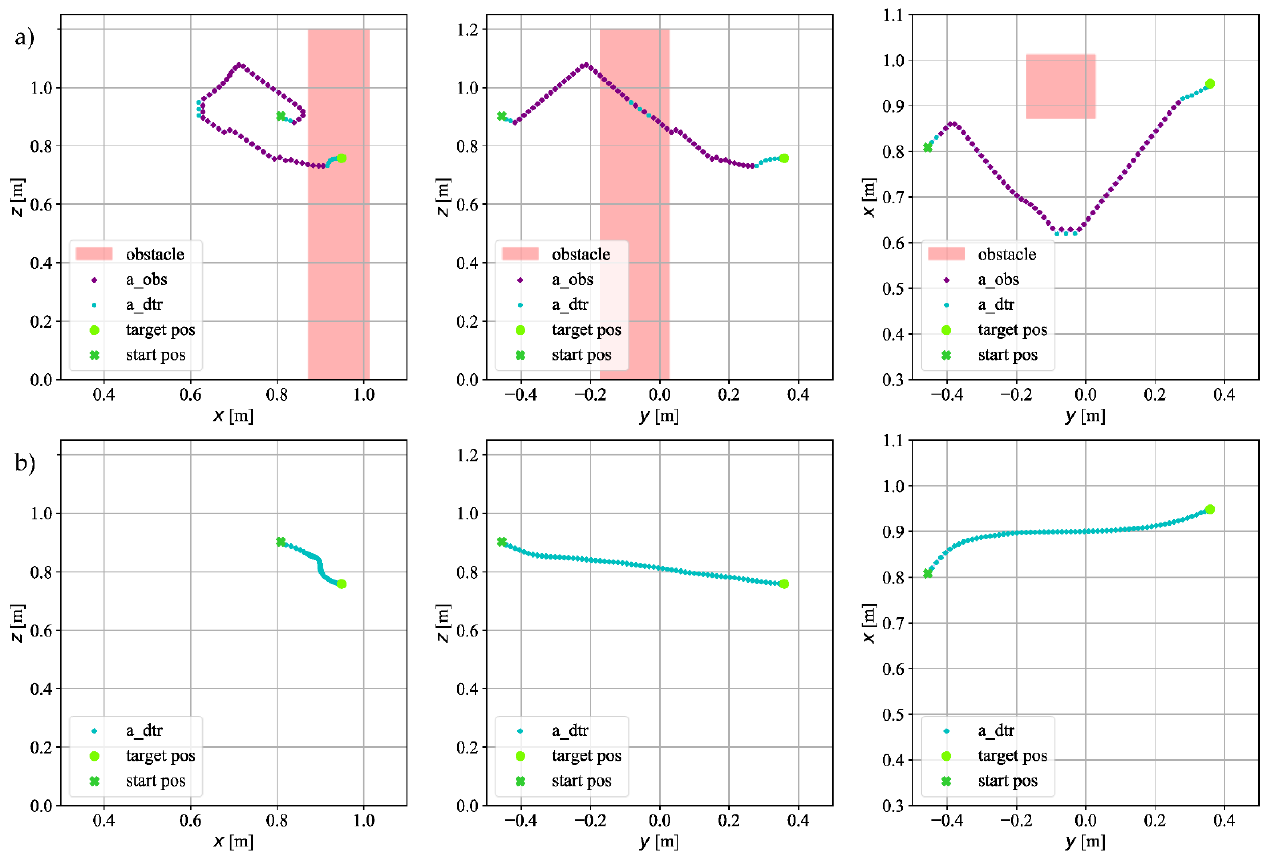
Figure 8. The trajectory on which the TCP of the robot moved in simulation for goal point 𝑔 1 : ( a ) with an obstacle; ( b ) without an obstacle.